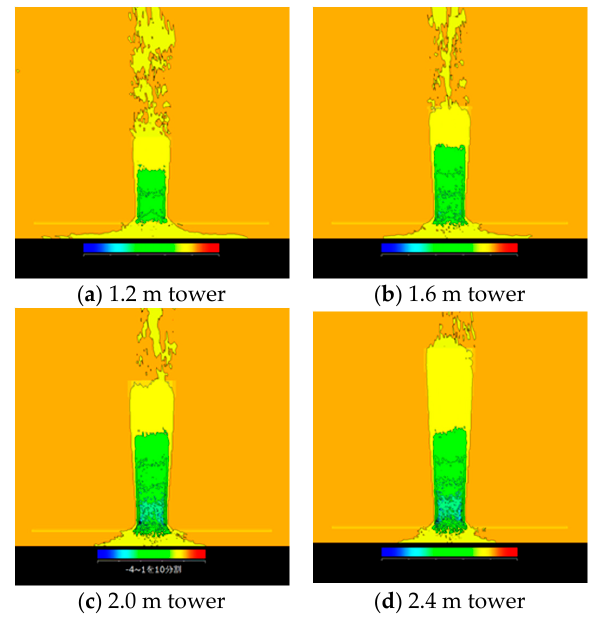
Figure 14. Instantaneous static pressure field of updraft inside the tower with a semi-open angle 4° for each tower height of ( a ) 1.2 m; ( b ) 1.6 m; ( c ) 2.0 m; and ( d ) 2.4 m. The static pressure is expressed by 10 intervals between dimensionless pressure − 4 (blue) and 1 (red).